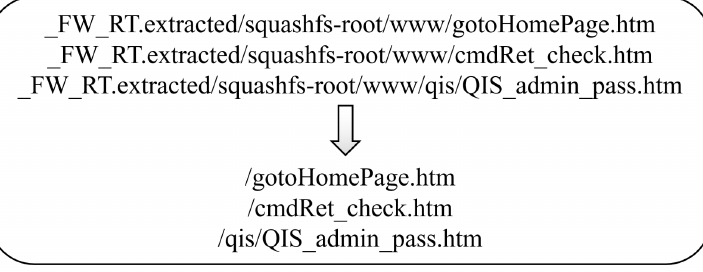
Figure 1. Process from page path to web path in ASUS RT-N53 router.